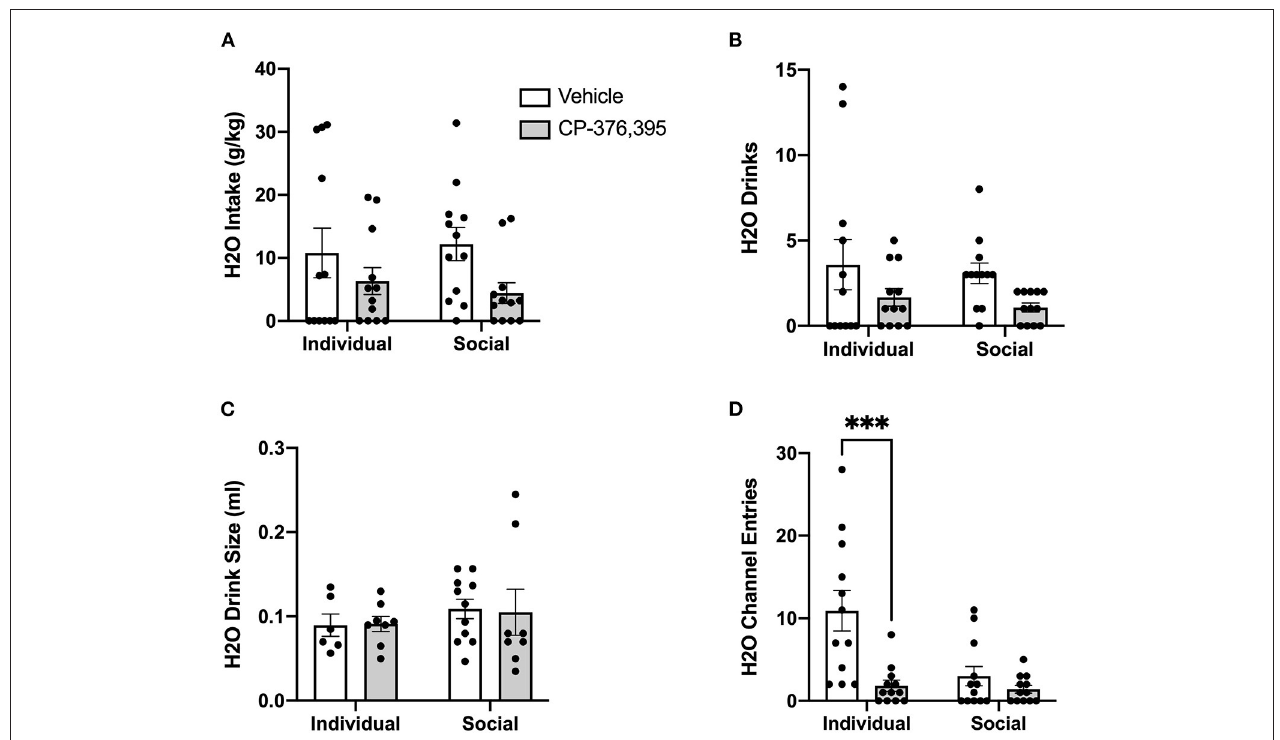
FIGURE 12 | Three hour cumulative water data post-CRFR1 antagonism. (A) Water intake in mls. (B) Water intake in g/kg. (C) Number of water drinks. (D) Water drink size in mls. (E) Water channel entries. During the first 3 h post-treatment, CRFR1 antagonism caused decreases in g/kg water intake and the number of water drinks across both housing conditions, with water drink size remaining unaffected. This treatment also caused a selective decrease in non-consummatory channel entries for the individually-housed group. Data represented as mean ± SEM. n = 12/group.